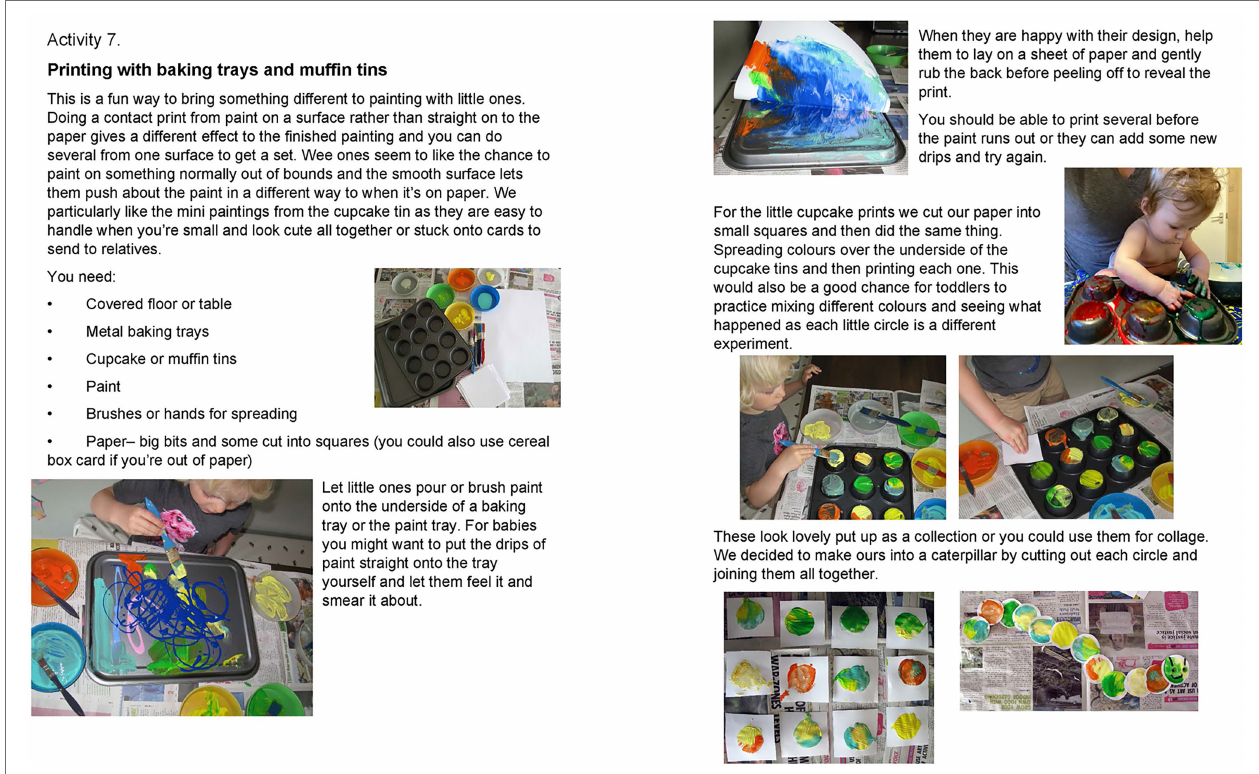
FIGURE 4 | Sample pages of Art Box